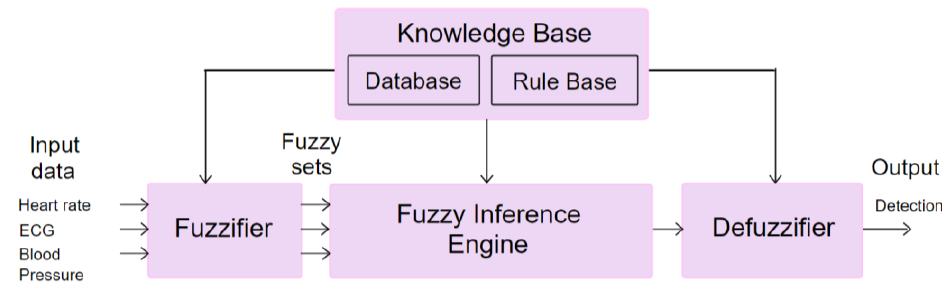
Figure 2. FIS for heart disease risk prediction.